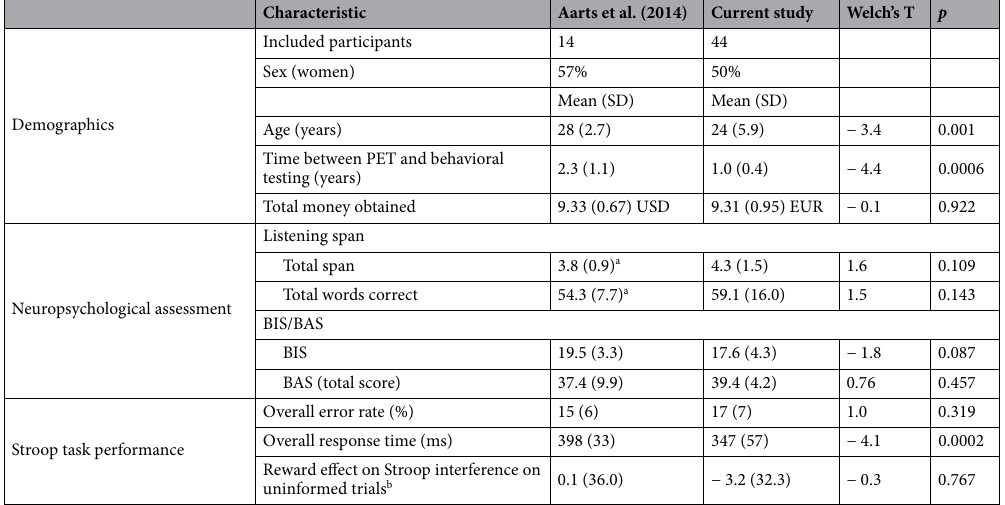
Table 1. Demographic, background and task characteristics of participants included in the behavioral analyses. Neuropsychological assessment included the listening span task 42 and the Behavioral Inhibition Scale/Behavioral Activation Scale (BIS/BAS; 43 ). a 1 missing value. b Average RT incongruent trials minus average RT congruent